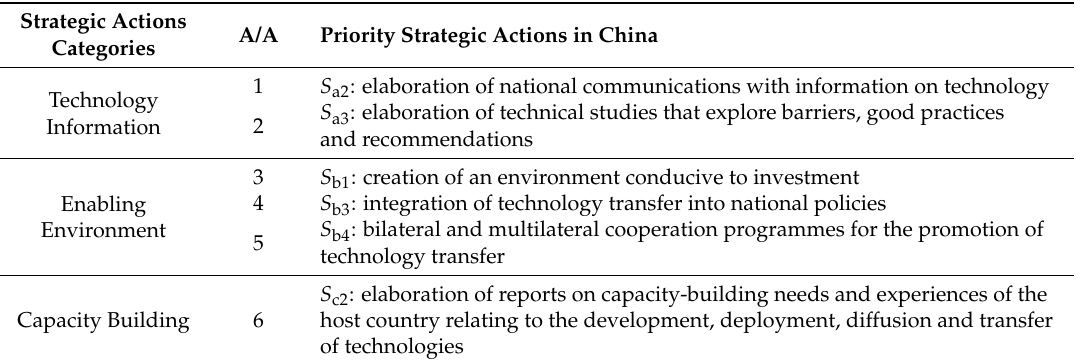
Table 4. Priority strategic actions for the promotion of technology transfer in